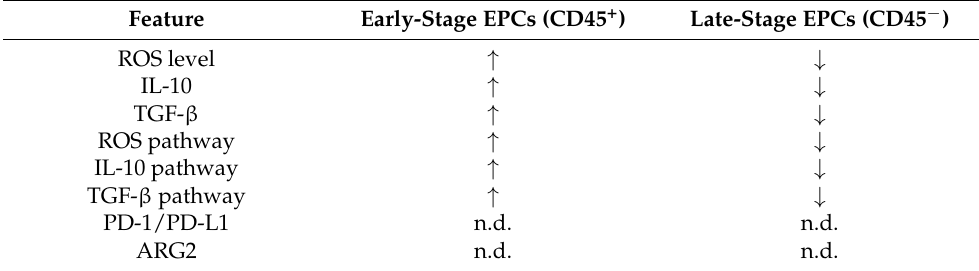
Table 4. Differences in immune-related mediators between early-stage and late-stage EPCs